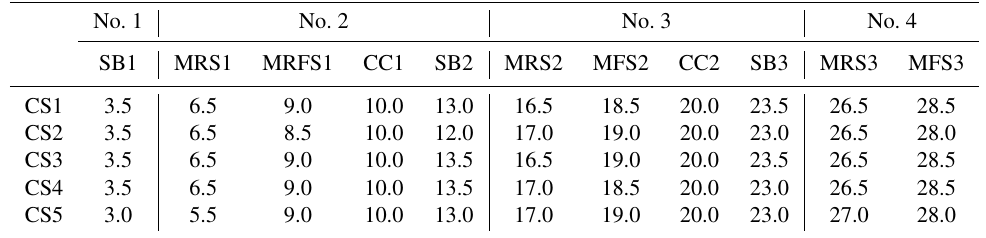
Figure 10. Stratal stacking patterns on five dip-oriented cross sections (CS1 to CS5) and two along-strike cross sections. Key stratigraphic surfaces on CS1 to CS5 are identified and coloured accordingly. Table 1. Timing of stratigraphic surfaces on CS1 to CS5